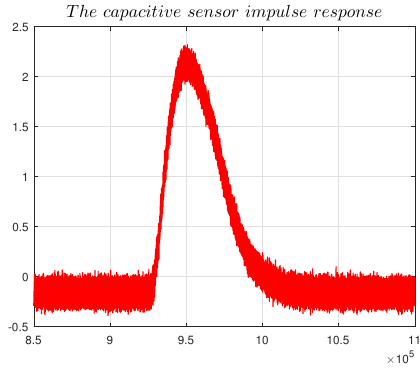
Figure 25. The temperature